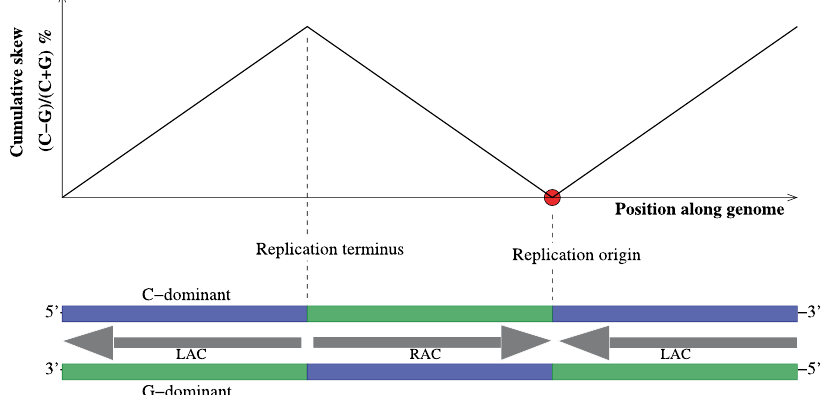
Figure 9. Schematic diagram illustrating the experimental observations related to GC skew in various genomes. The genome is composed of independently replicating subunits, usually refered to in biological literature as “replichores”, three of which are shown here colored in blue and green. The replichore that is enriched in C is denoted in blue, and in G , green. The sign of GC skew has been observed to correlate with the direction of replication along a template strand. Leading strand templates, the segments where replication and unzipping machineries travel in the same direction, have been observed to be enriched in the nucleotide G . Lagging strands, where these two machineries travel in opposite direction, must then be enriched in C . It has also been observed that only one of the boundaries between the replichores function as origin of replication, whereas the other, as replication terminus. The schematic graph above the strands illustrate the cumulative GC skew, calculated in running windows of appropriate size over the entire genome. It is representative of skews observed in genomes of multiple species, and clearly shows the boundaries between replichores. The GC skew has traditionally been attributed to the difference in replication mechanisms between the leading and lagging strands. All these observations are understandable within our picture of sequence-dependent asymmetric cooperativity, where GC skew is treated as the cause of unzipping directionality. The arrows between the two strands, labeled RAC and LAC, denote the right and left modes of sequence-dependent asymmetric cooperativity respectively. At the origin of replication, pointed by a red dot on the graph above, the asymmetric cooperativities reduce the barrier from both left and right, rendering the bonds at the interface weaker and thereby allowing the interface to function as the origin. At the terminus, the barrier height for the hydrogen bonds are raised from both directions and can be broken only when the neighboring bonds are